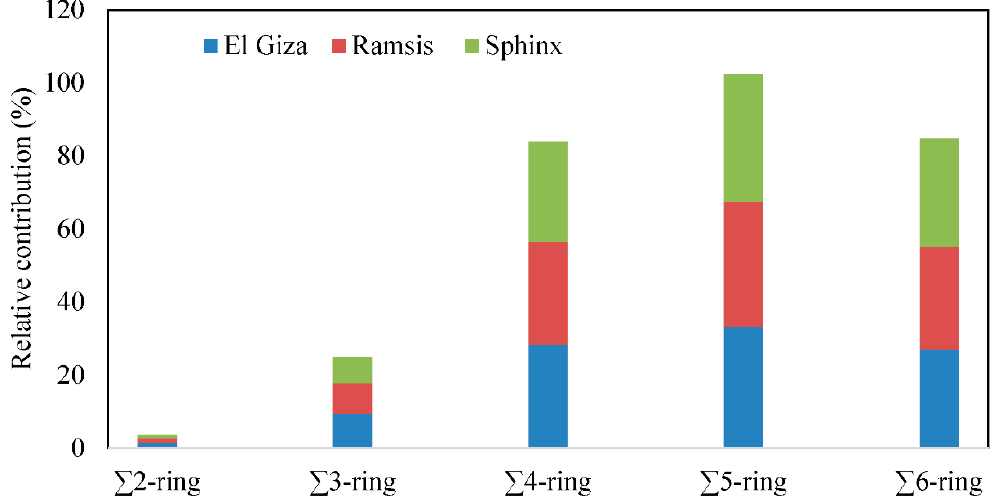
Figure 5. Relative contribution of the individual PAH compounds to the total concentrations of the PAH compounds in total suspended particulate at El Giza, Ramsis, and Sphinx Square.